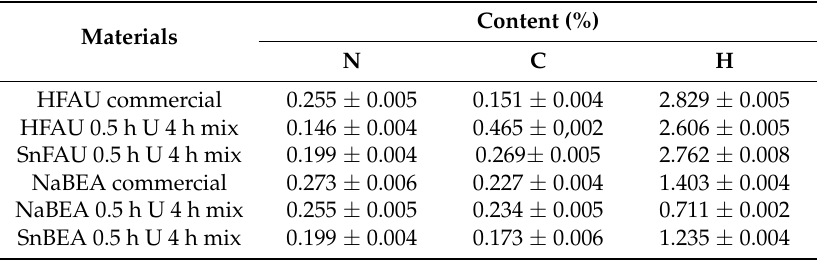
Table 1. Percentage content of nitrogen, carbon and hydrogen in hierarchical zeolites.